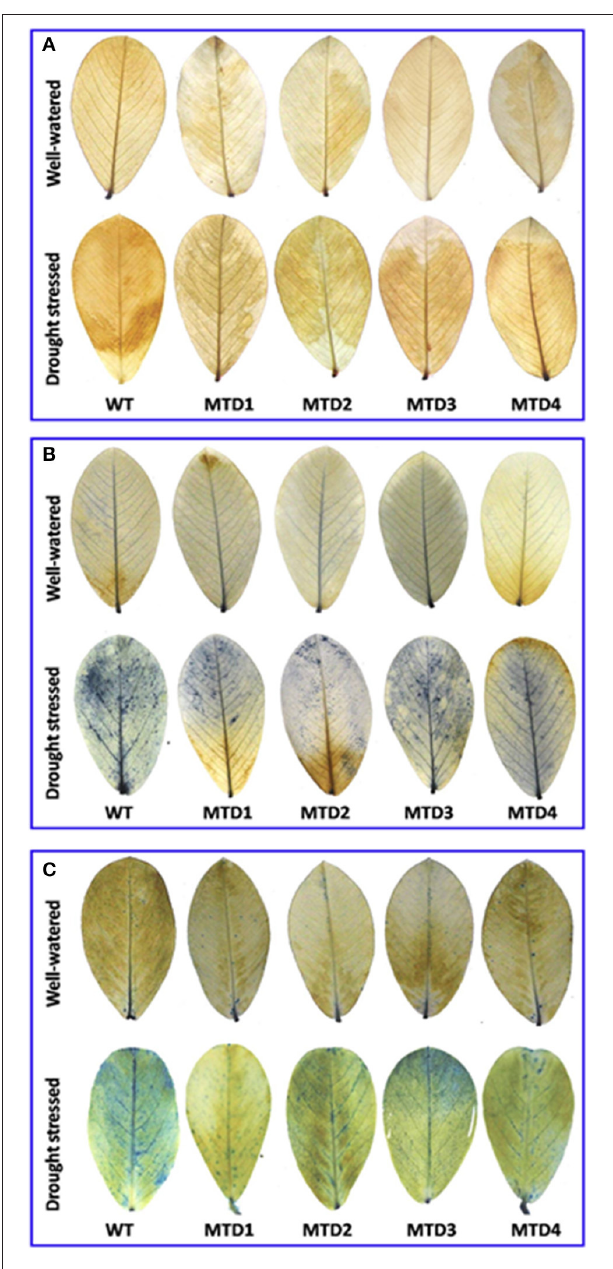
FIGURE 2 | In situ localization of hydrogen peroxide (A) and the detection of superoxide radicals (B) and cell-death (C) in wild-type and transgenic lines under well-watered and drought stressed condition using DAB, NBT, and trypan blue staining, respectively.